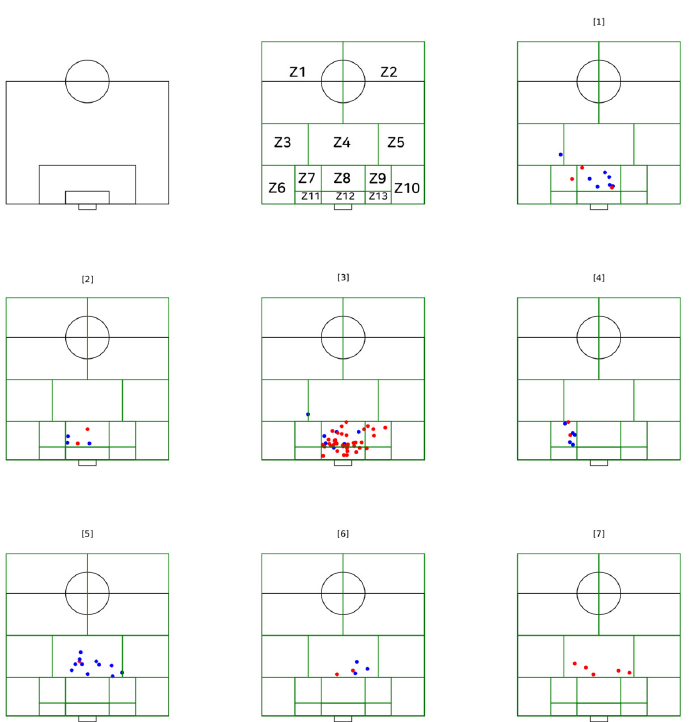
Figure 2. Number of goals and internal node.